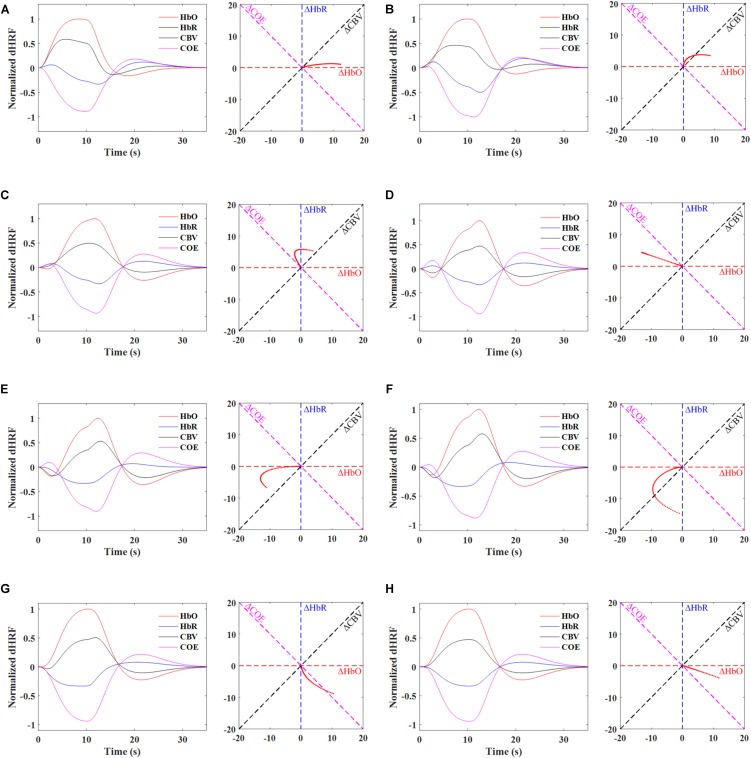
Phase diagrams depicting the ideal trajectories (0 to 4 s) of individual phases using dHRF-based HbO and HbR, Phases 1∼5 represents the initial dip response and Phases 6 and 7 denote the conventional hemodynamics response: (A) Phase 1, 0 < ΔHbR < ΔHbO, ΔCOE < 0 < ΔCBV, (B) Phase 2, 0 < ΔHbO < ΔHbR, 0 < ΔCOE < ΔCBV, (C) Phase 3, ΔHbO < 0 < ΔHbR, 0 < ΔCBV < ΔCOE, (D) Phase 4, ΔHbO < 0 < ΔHbR, ΔCBV < 0 < ΔCOE, (E) Phase 5, ΔHbO < ΔHbR < 0, ΔCBV < 0 < ΔCOE, (F) Phase 6, ΔHbR < ΔHbO < 0, ΔCBV < ΔCOE < 0, (G) Phase 7, ΔHbR < 0 < ΔHbO, ΔCOE < ΔCBV < 0, and (H) Phase 8, ΔHbR < 0 < ΔHbO, ΔCOE < 0 < ΔCBV.